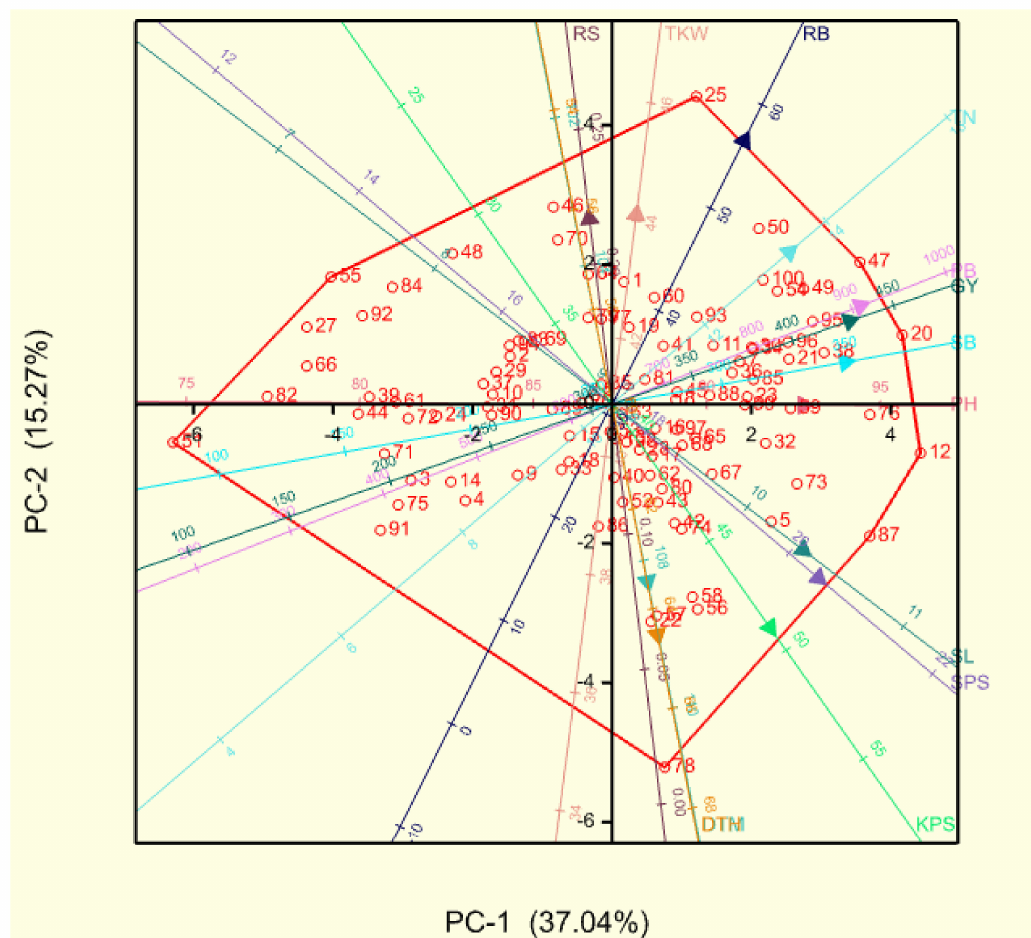
Figure 2. Principal component biplot of 10 bread wheat parental lines and 90 F 2 families under non-stressed conditions. Genotypes are coded with numbers, as recorded in Table S1. Smaller angles between vectors of recorded traits indicate a high correlation between the traits in discriminating genotypes. Genotypes plotted closer to and further along a vector line scored highly in that partic- ular trait. PC = principal component, DTH = days to 50% heading, DTM = days to 50% maturity, PH = plant height (cm), TN = tiller number, SL = spike length (cm), SPS = spikelets per spike, KPS = kernels per spike, TKW = thousand kernel weight (g), SB = shoot biomass (g · m − 2 ), RB = root biomass (g · m − 2 ), PB = total plant biomass (g · m − 2 ), RS = root-to-shoot ratio and GY = grain yield (g · m − 2